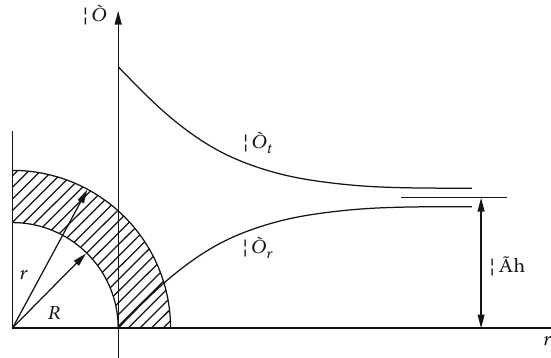
Figure 2: Schematic diagram of stress distribution in surrounding rock of